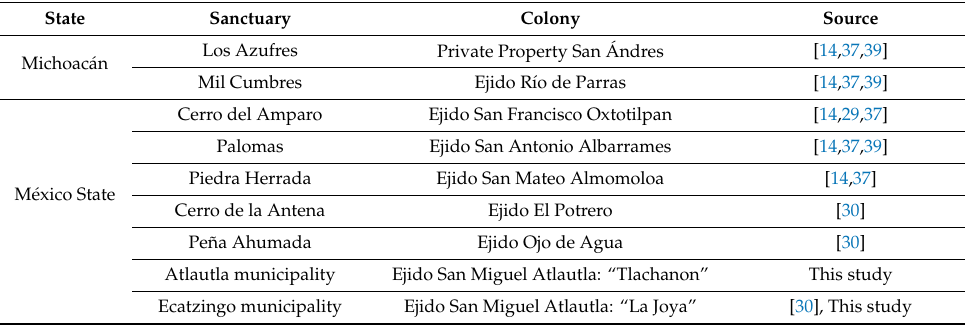
Table 2. Reported sites for wintering of the monarch butterfly outside the MBBR.